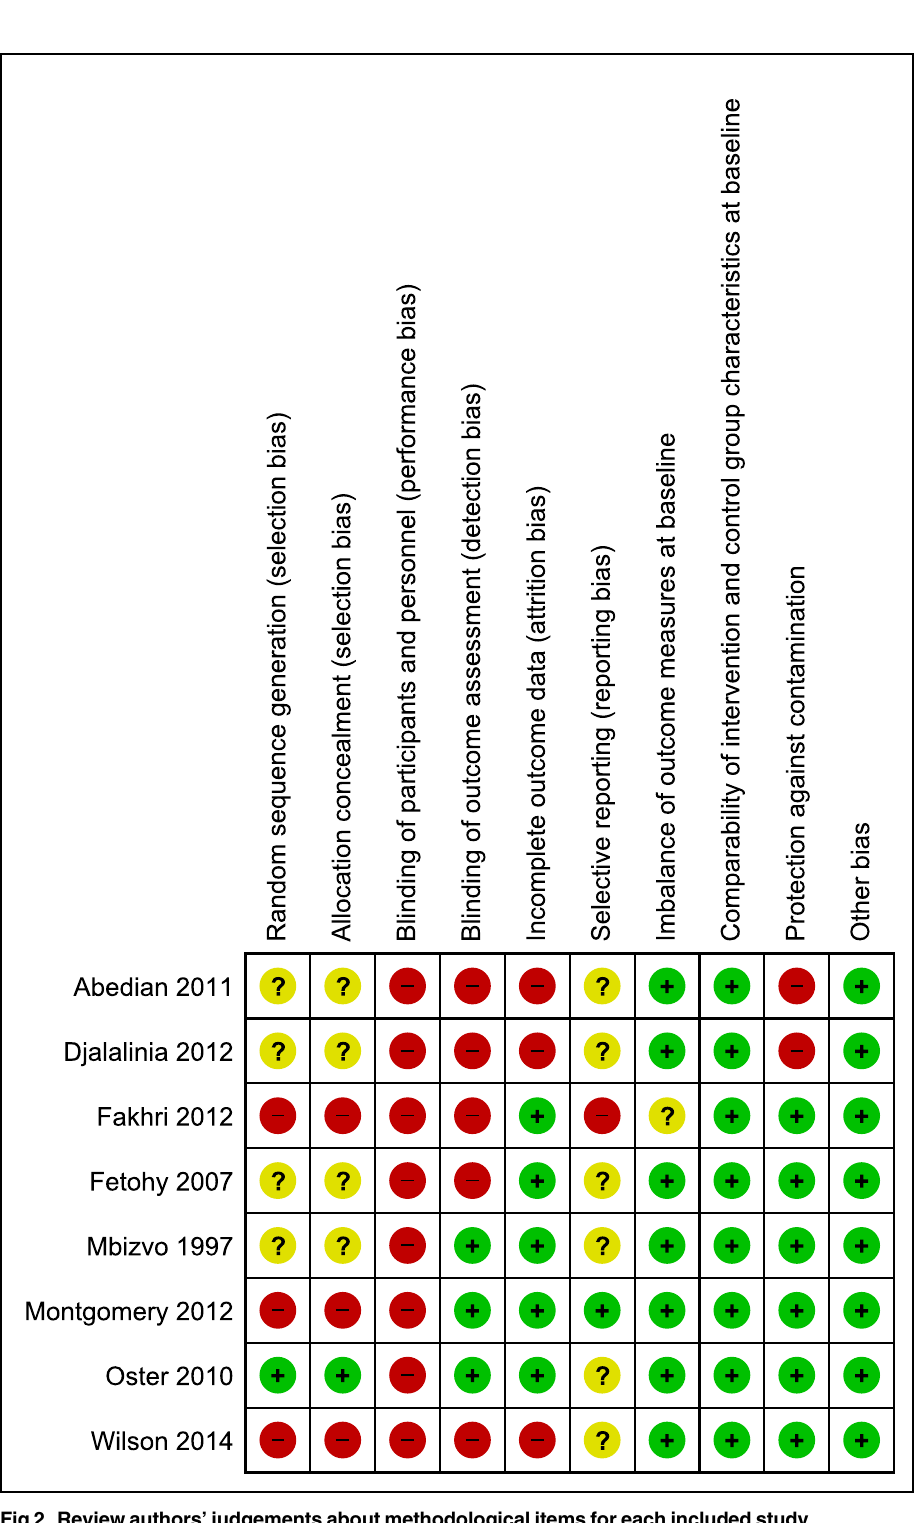
Fig 2. Review authors ’ judgements about methodological items for each included study.